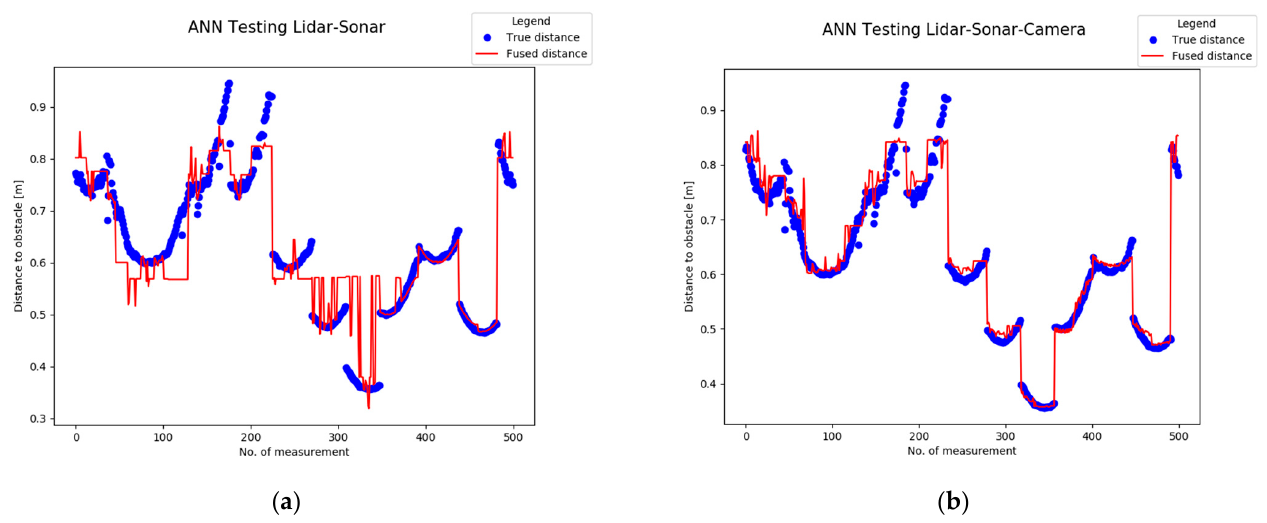
Figure 36. Analytical performance evaluation of the neural network by comparing the ground truth distance and fused distance: ( a ) LiDAR-Sonar model; ( b ) LiDAR-Sonar-Camera model.